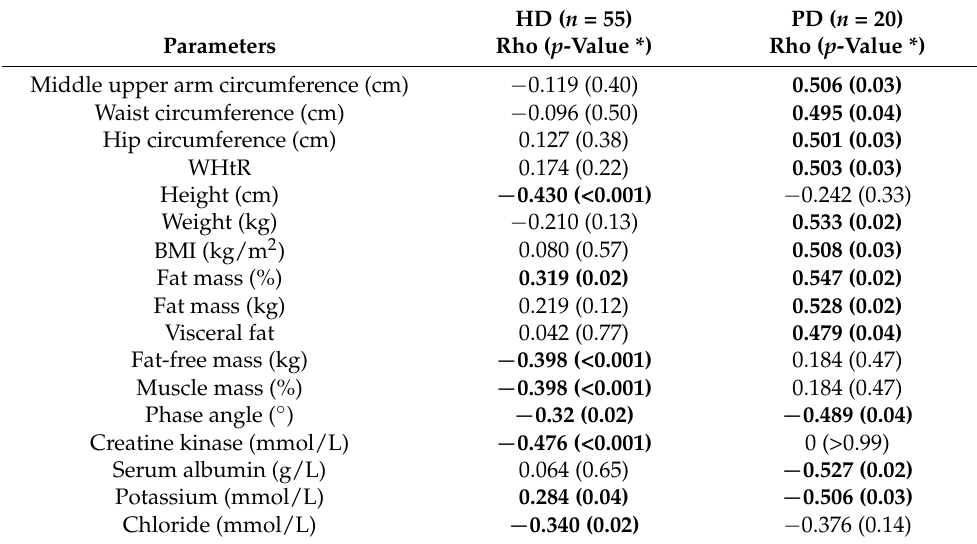
Table 5. Significant correlations between depressive symptoms and measured